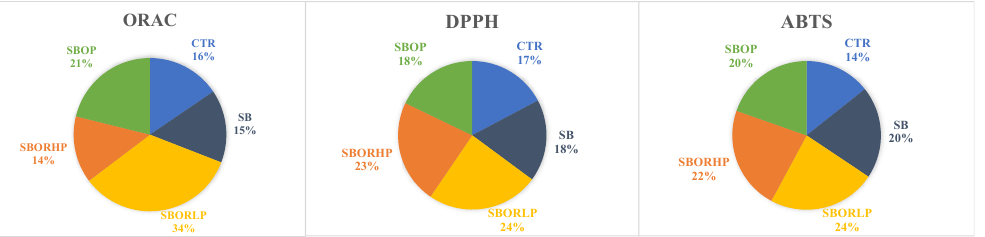
Figure 3. Antioxidant activities (ORAC, DPPH and ABTS) detected in red onion bulbs differently fertilized: control (CTR), sulphur bentonite (SB), sulphur bentonite-low percentage orange residue (SBOR LP), sulphur bentonite-high percentage orange residue (SBOR HP), and sulphur bentonite- olive pomace (SBOP). Data are the mean of three replicates.